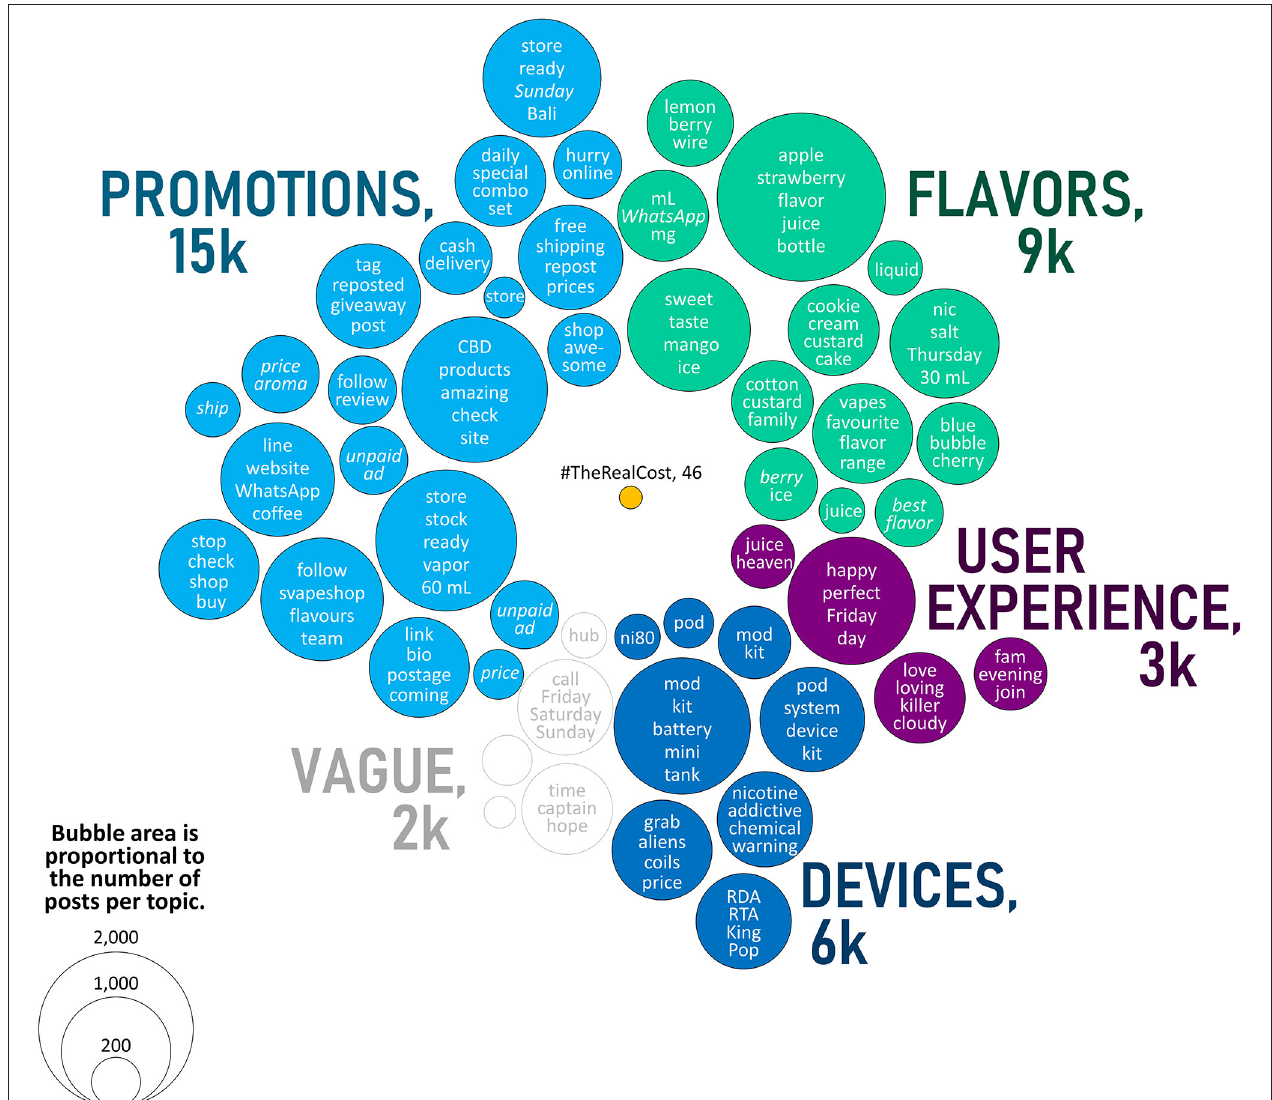
FIGURE 3 | The number of Instagram posts from the March 2019 sampling period belonging to each topic as defined by latent Dirichlet allocation analysis of caption text. Here, topics are further organized into informal themes based on the five most-commonly used words from each topic (representative words are displayed). For comparison, only 46 posts in this sample used the hashtag #TheRealCost. Words shown in italic font were translated to English from the original caption text composed in another language (i.e., from Spanish, German, French, Italian, Malay, or Indonesian).